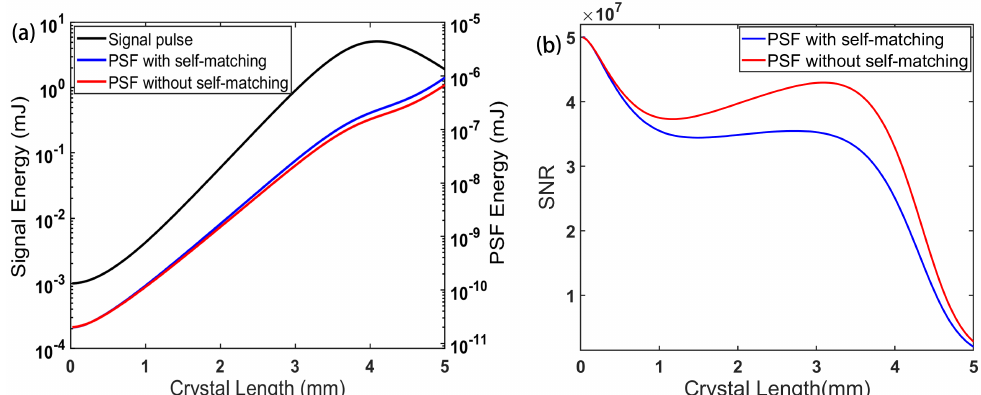
Figure 2. ( a ) The signal energy and PSF energy versus the crystal length. The black line represents the signal energy. The blue line represents the PSF energy assuming that it has the perfect phase-matching condition. The red line represents the PSF energy assuming that it has the same phase mismatch with signal. ( b ) The signal-to-noise energy ratio (SNR) versus the crystal length. The blue line represents the case that PSF has perfect phase-matching condition. The red line represents the case that PSF has the same phase mismatch with signal.